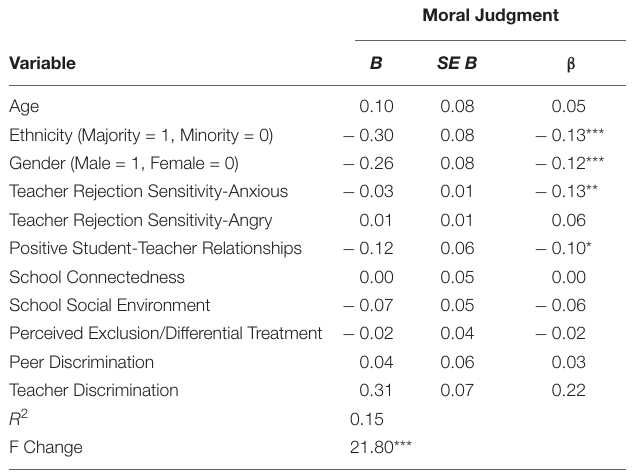
TABLE 2 | Moral judgment of social exclusion.